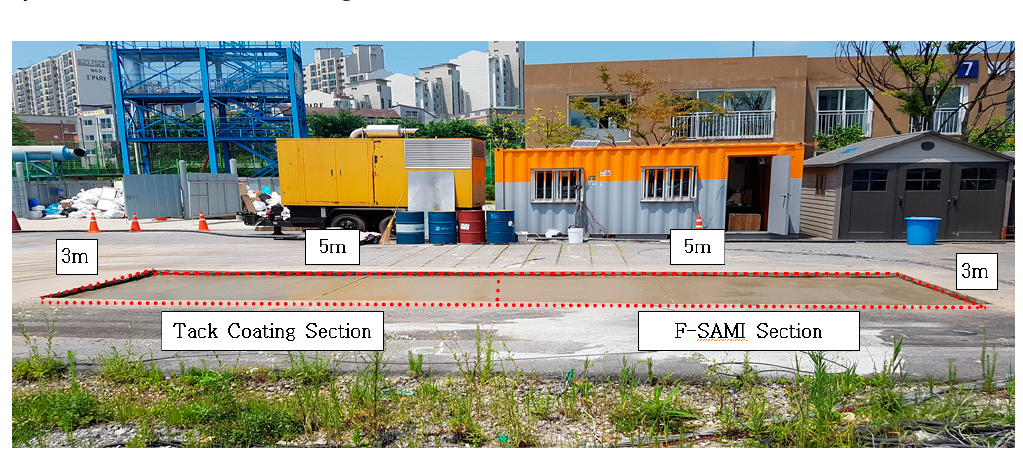
Table 4. Materials and grade for APT test section.